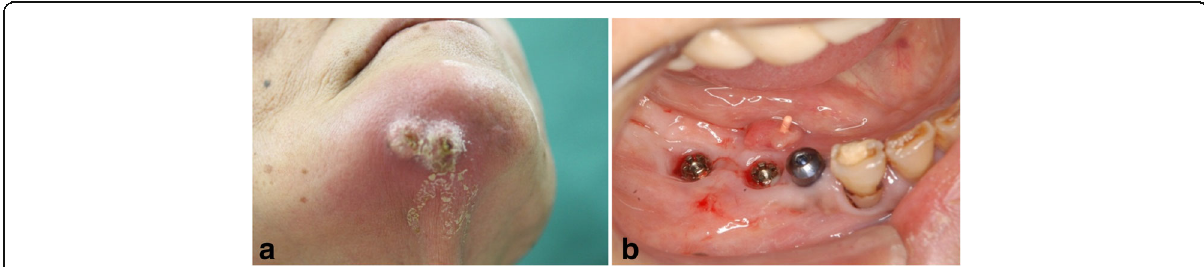
Fig. 1 a Extraoral photograph showing an extraoral fistula in the right mandibular region. b Intraoral photograph showing an intraoral fistula on the lingual side of the distal dental implants associated with mucosal inflammation and a purulent